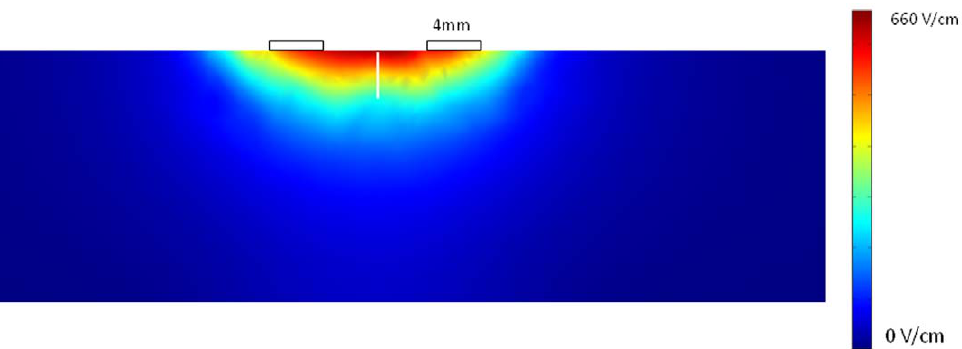
Figure 3. Calculated mean temperature versus time of rat liver treated by 200 pulses of 25 and 50 m s at pulse potential of 500 V with repetition rate of 1 Hz. Following a mild increase in temperature, there is a rapid relaxation of temperature to baseline.